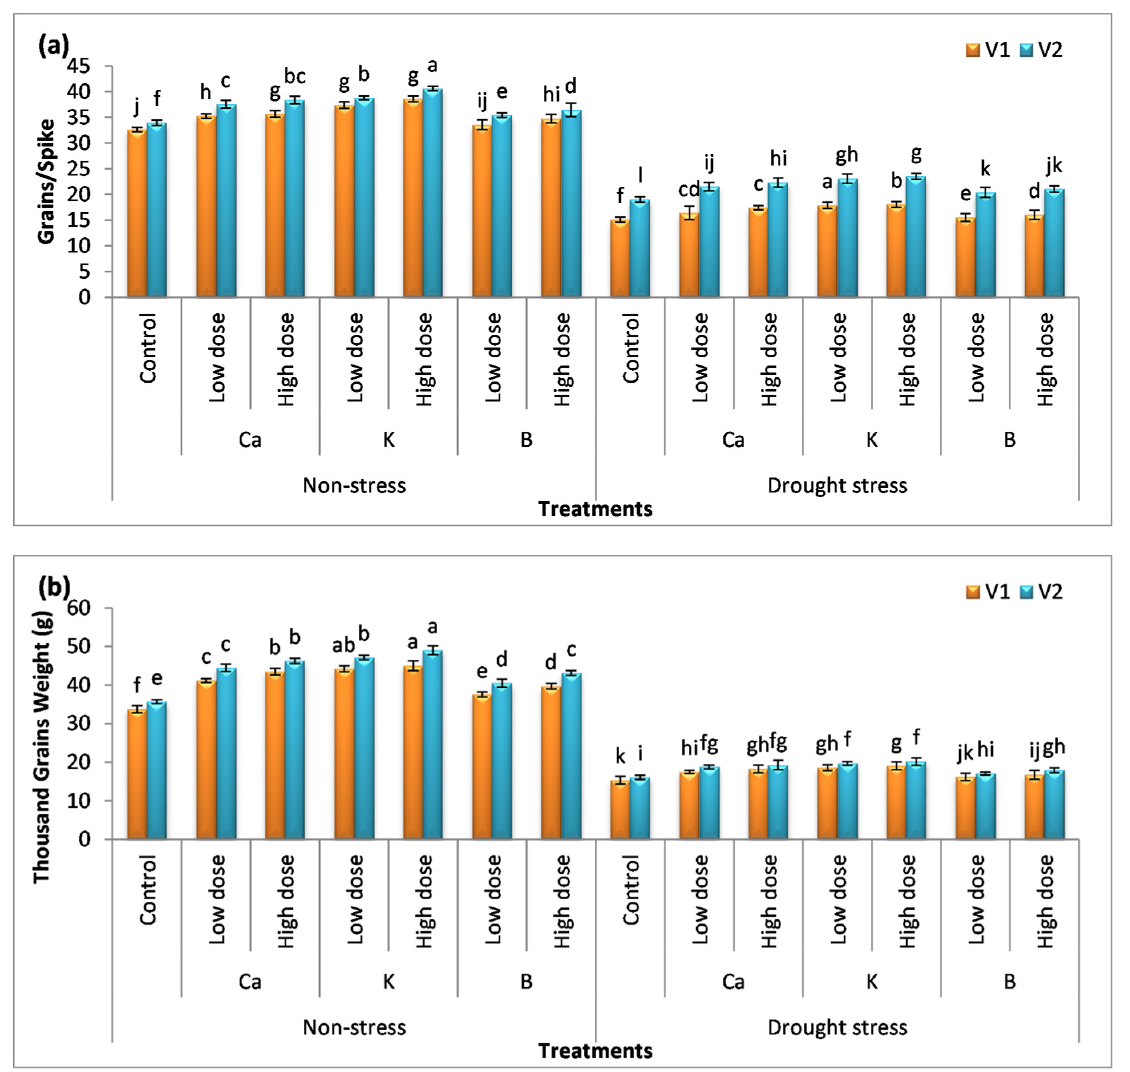
Figure 6. Effect of Ca, K, and B on yield attributes of durum wheat. The figures include ( a ) number of grains per spike and ( b ) 1000-grain weight of durum wheat, where V1 = Preco and V2 = Kronos. The different letter shows significant difference among the mean values of treatments.